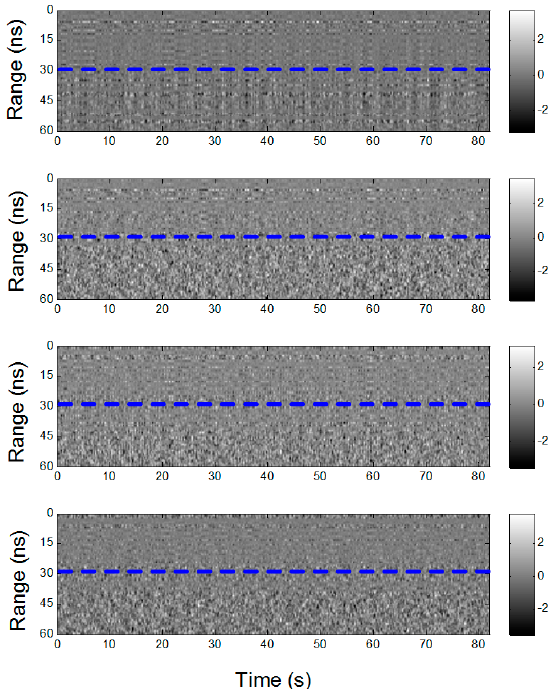
Figure 7. UWB data after the preprocessing. The rows from top to bottom correspond to the data of channel 1, 2, 3 and 4, respectively. The blue broken line indicates the waveforms manually picked on the basis of the a priori range information of the target.